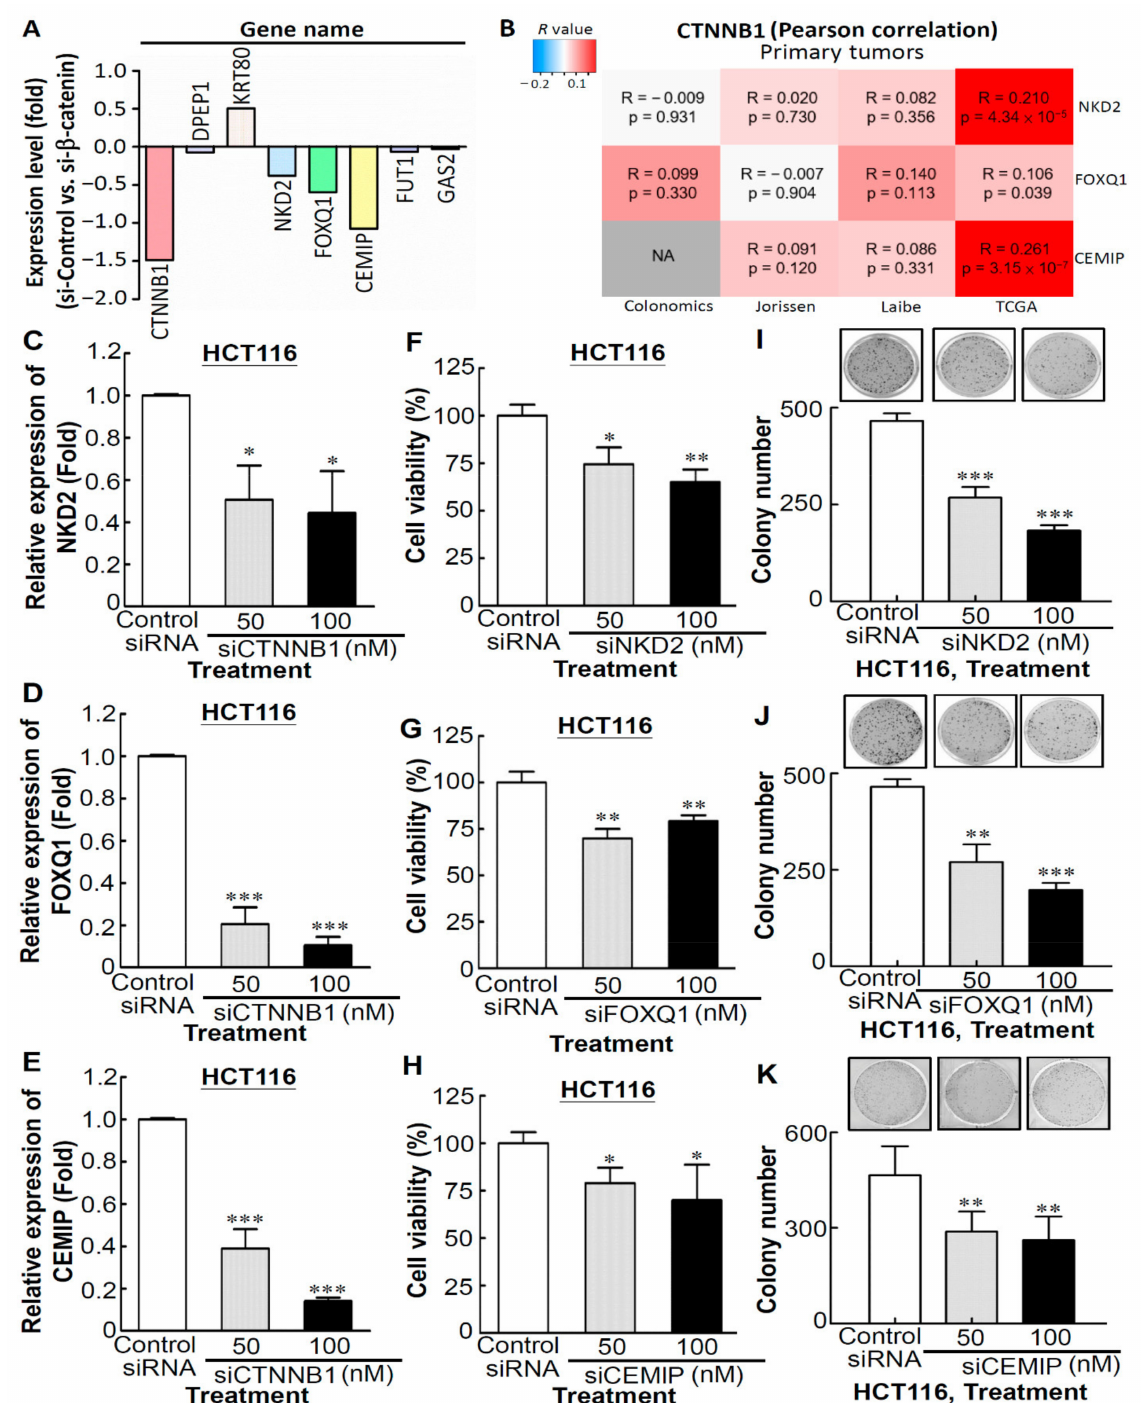
Figure 7. CTNNB1 plays a critical role in regulating the expression of NKD2, FOXQ1, and CEMIP in CRC cells ( A ) CTNNB1 and seven positive expression correlation genes transcripts in CTNNB1 knockdown SW480 cells. ( B ) Heatmap showing the correlation between CTNNB1 and corresponding target genes of CTNNB1 in multiple CRC clinical datasets. Red color indicates positive correlation, and blue color indicates negative correlation, with color intensity representing the Pearson’s correlation value (R), as indicated by the scale on the upper left corner. ( C – E ) Expressions of representative genes ( NKD2 , FOXQ1, and CEMIP) in CTNNB1-knockdown HCT116 cells. Cell viability assay was performed to determine the proliferation of NKD2 ( F ), FOXQ1 ( G ) or CEMIP ( H )-depleted HCT116 cells. The colony-forming assay was performed to determine the effects of NKD2 ( I ), FOXQ1 ( J ), or CEMIP ( K )-depletion of the growth of HCT116 cells. * p < 0.05, ** p < 0.01, *** p <